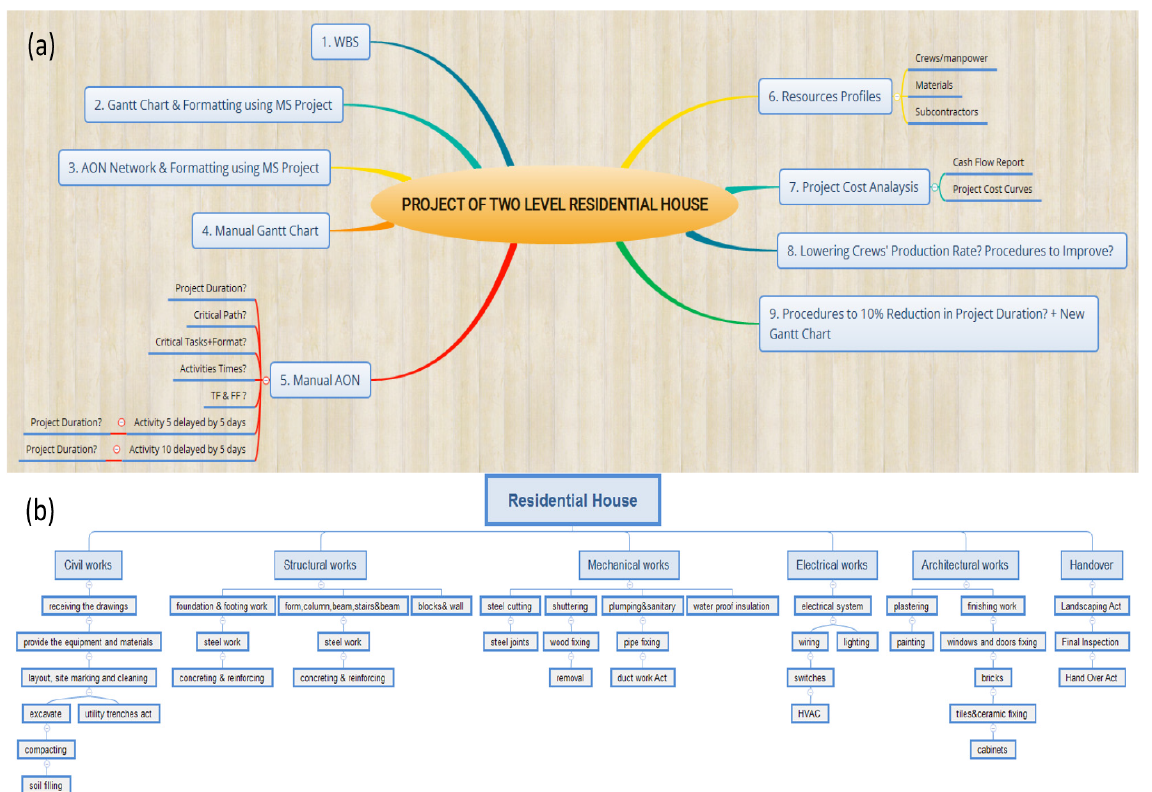
Figure 4. Examples of using the Xmind tool in coursework; a) faculty work, and b) students’